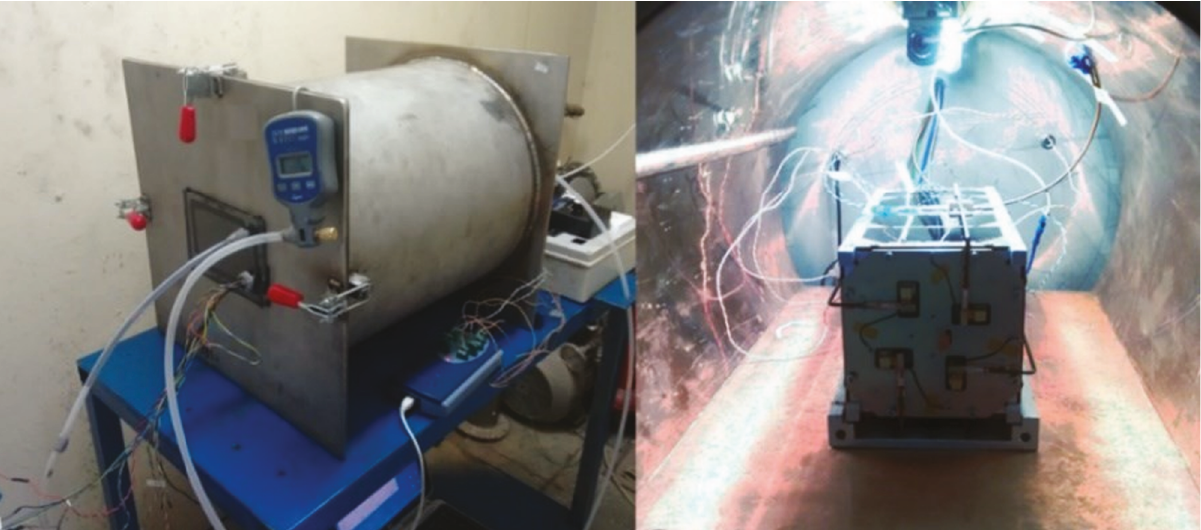
Figure 17: Thermal vacuum chamber (setup and internal view).